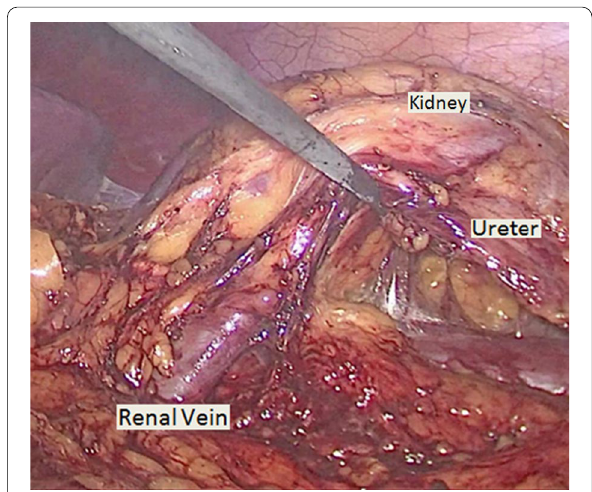
Fig. 2 After reflecting the colon, the ureter is being followed till the pedicle in Lt LDN